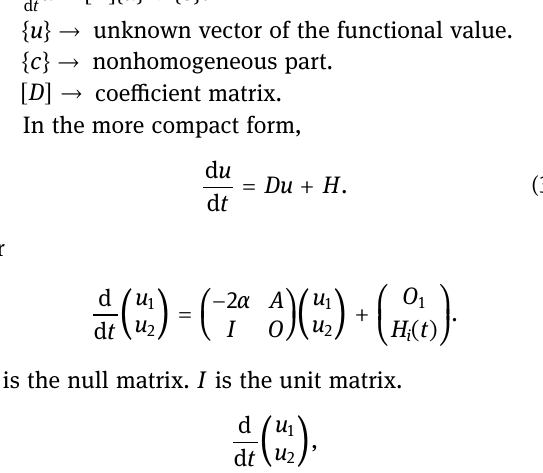
Table 18: Comparison of relative errors for = α 10 , = β 5 , = N 21 , = t Δ 0.0001 , and = τ 0.5 regarding Example